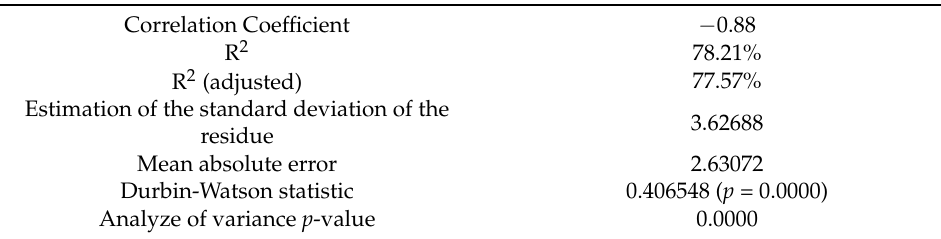
Table 6. Regression simple linear